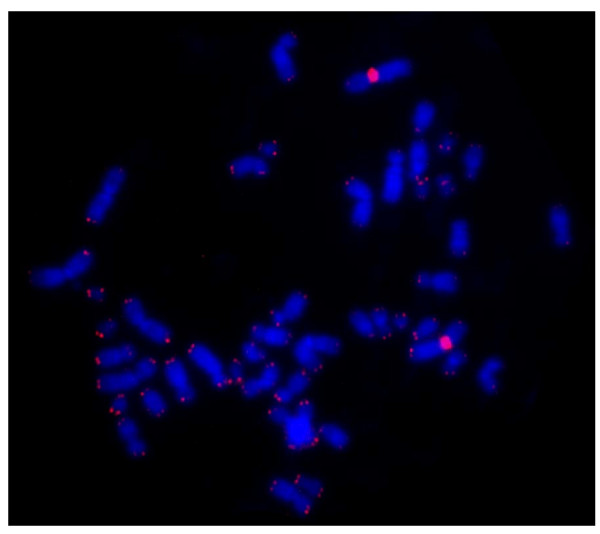
U373 metaphase hybridized with telomere PNA probe labeled with Cy3. Co-hybridisation was done with Cy-3 telomeric-PNA probe and Cy-3 centromeric-PNA(cromosome 2) probe.